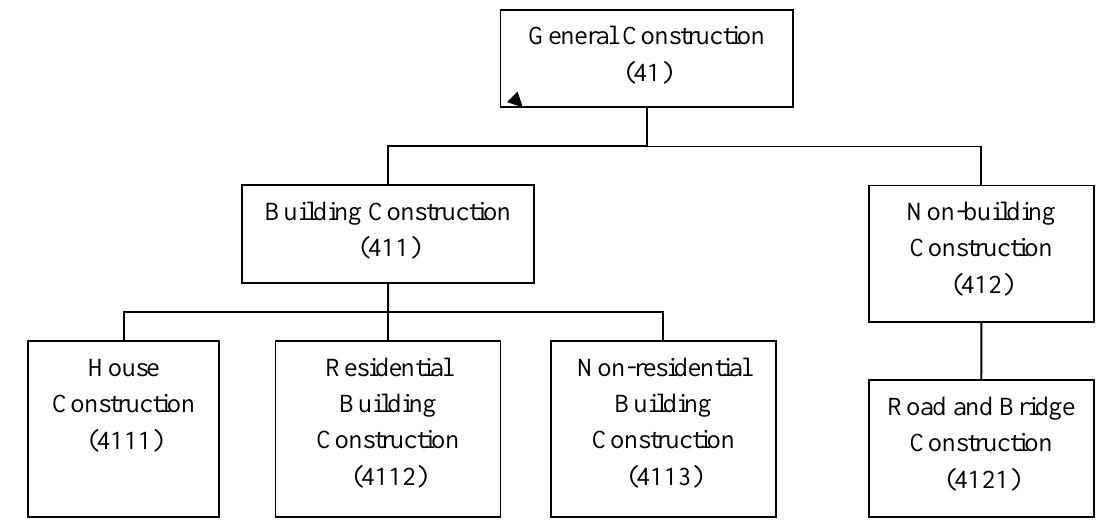
Figure 1 Structure chart of producer price indices of the general construction industry in Australia